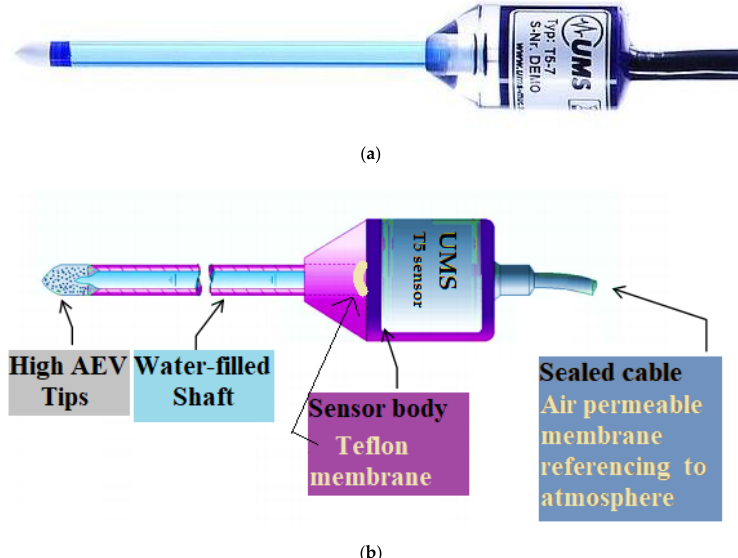
Figure 4. The hydraulic connective tensiometer [65] : ( a ) T5 sensor; ( b ) an illustration of a T5 sensor.